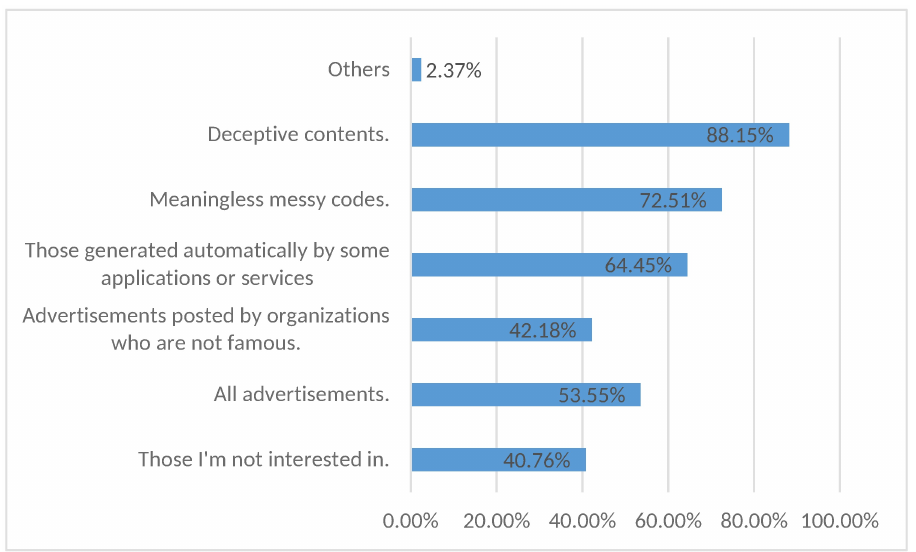
Fig 3. Users’ definition for low-quality content (Abstractcategories).